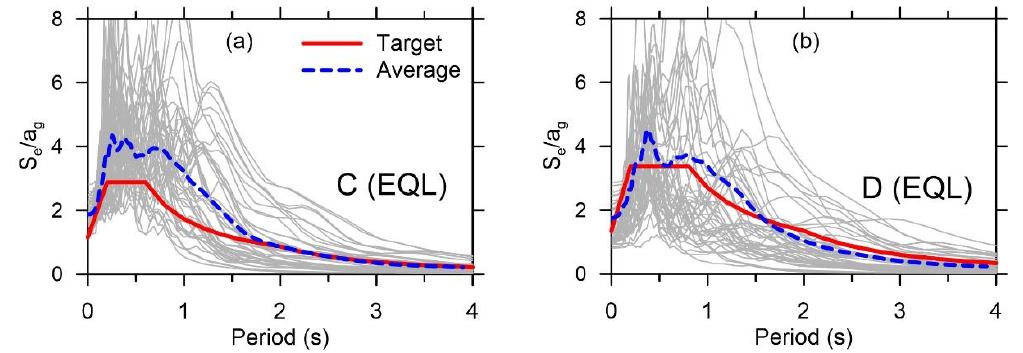
Figure 8. Spectral shapes from the equivalent linear (EQL) analyses with the design spectrum: ( a ) site classes C; ( b ) site classes D.